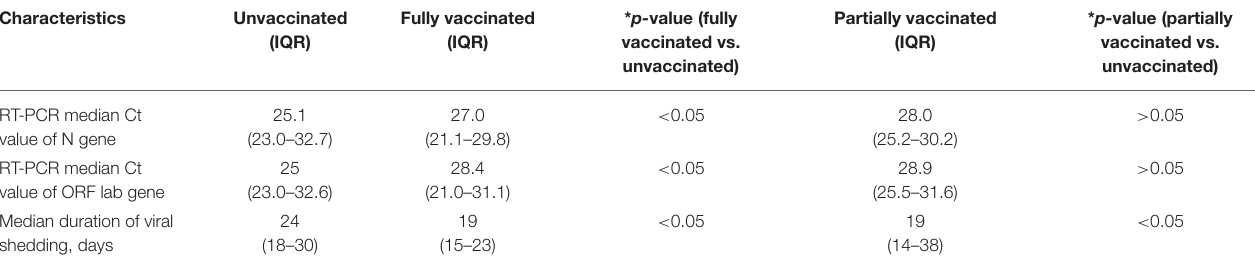
TABLE 4 | The viral load of the SARS-CoV-2 delta variant infected patients in different vaccination status in Jingmen City, Hubei Province, China in August 2021. Characteristics Unvaccinated